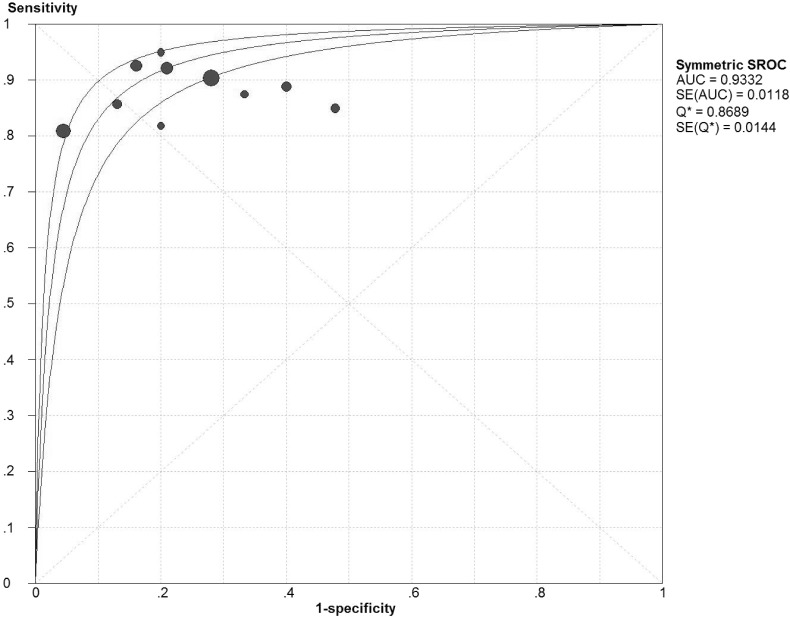
Summary receiver operator characteristics (SROC) of IGRA on summary estimates of sensitivity and specificity.AUC, area under the curve; SE, standard error